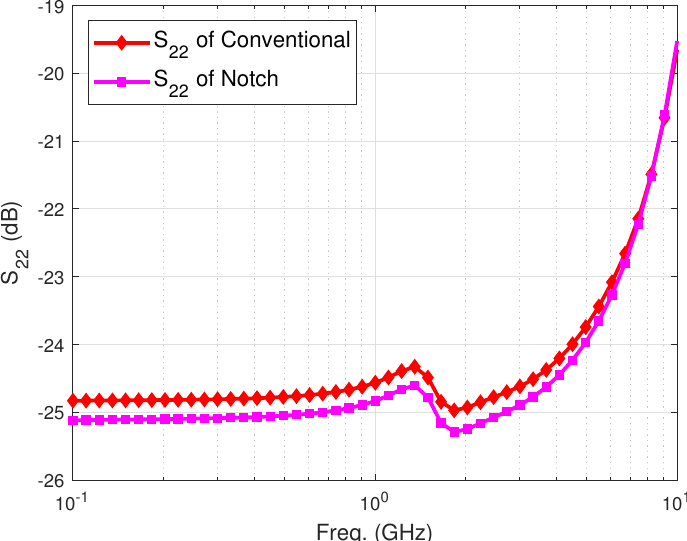
Figure 8. Output reflection (S 22 ) performance of the proposed notch LNA compared to the conventional